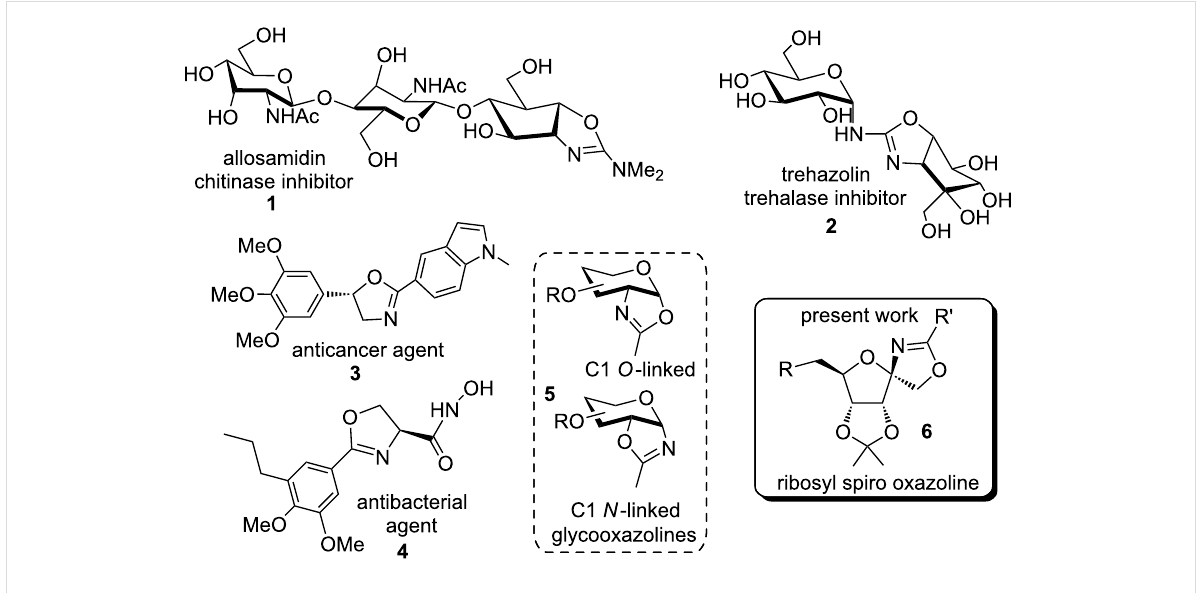
Figure 1: Some representative molecules having a 2-oxazoline moiety.